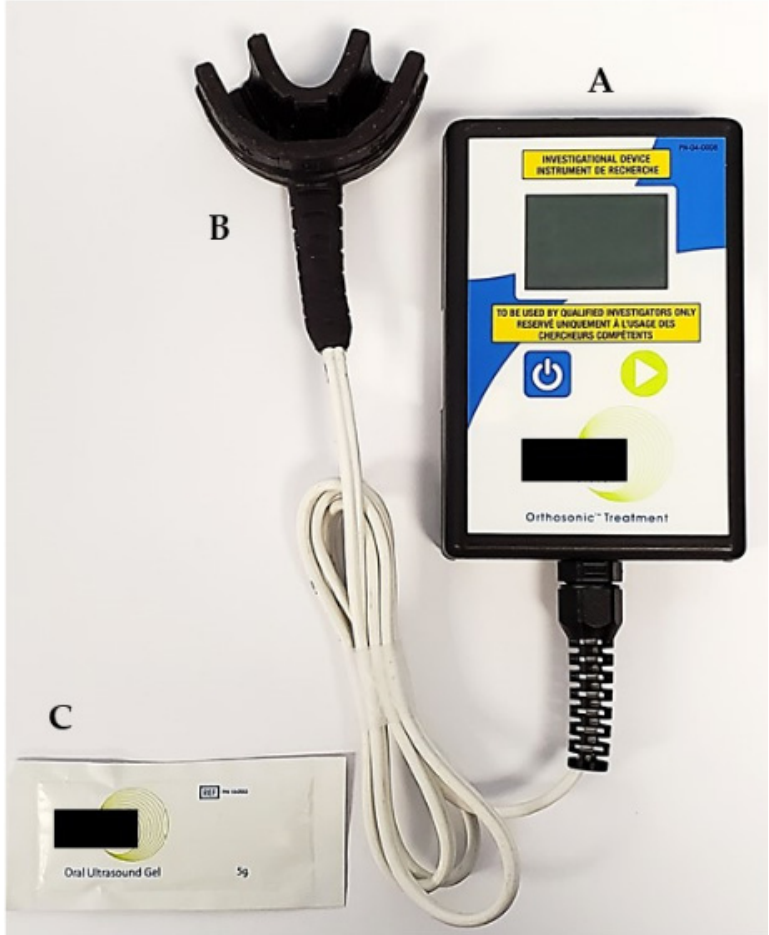
Figure 2. Low-intensity pulsed ultrasound (LIPUS) device used in the clinical trial including A : handheld electronics; B : mouthpiece containing LIPUS transducers; and, C : oral ultrasound